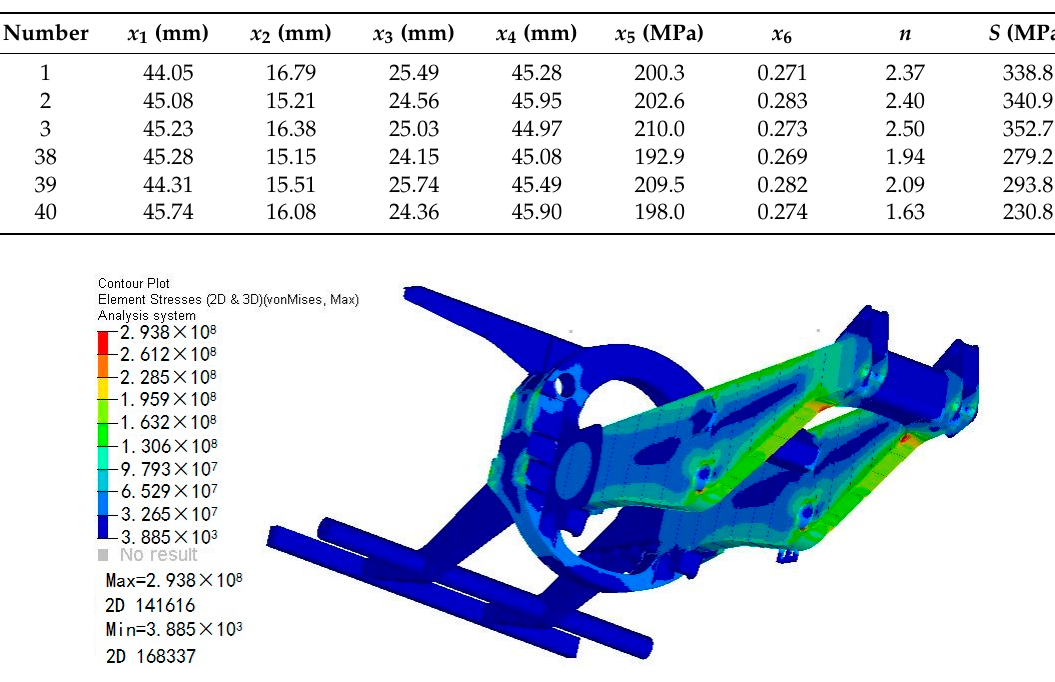
Table 6. Sample data and corresponding responses.